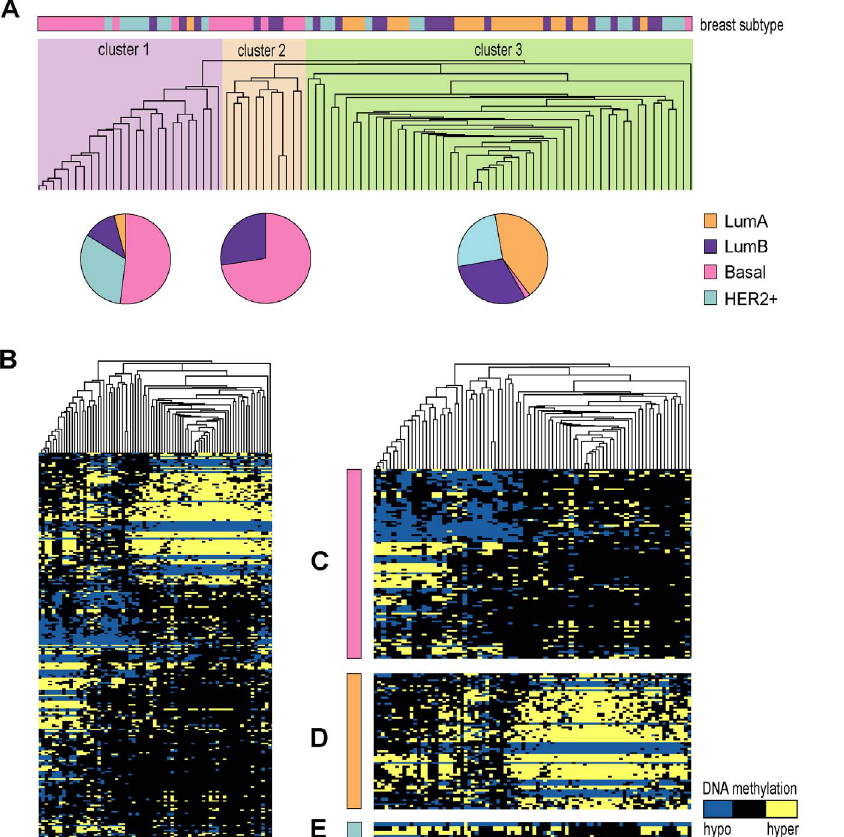
Figure 2. Hierarchical cluster analysis of the 88 tumor samples using discrete methylation profile of 222 driver genes. ( A ) Experimental dendrogram shows the clustering of the tumors into three subgroups: cluster 1(light purple, n=25); cluster 2 (orange, n=11); cluster 3 (light green, n=52). The pie charts show the distribution of sample subtypes within each cluster. (B) Overview of complete cluster diagram. (C) Basal- like subtype-specific driver genes. (D) Luminal-A subtype-specific driver genes. (E) HER2 + subtype-specific driver genes. doi:10.1371/journal.pone.0061214.g002 PLOS ONE |